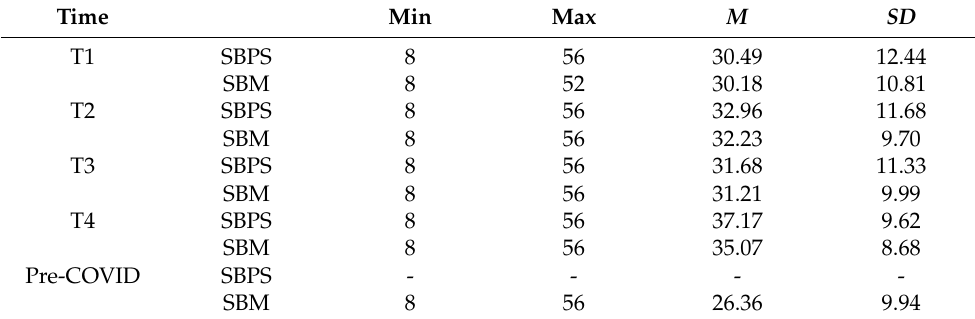
Table 2. Descriptive Statistics for Boredom at Each Time